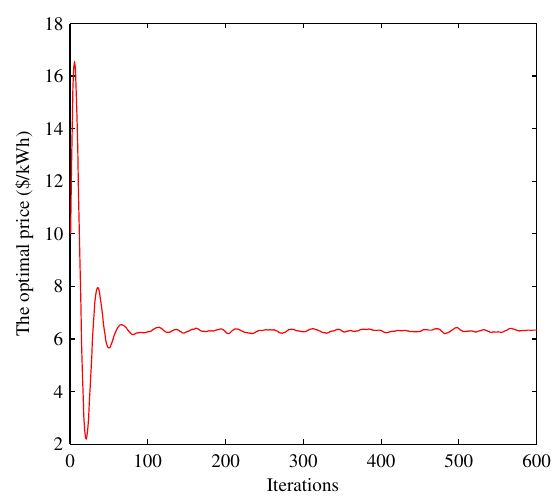
Figure 10. Convergence of the retail price under case II.